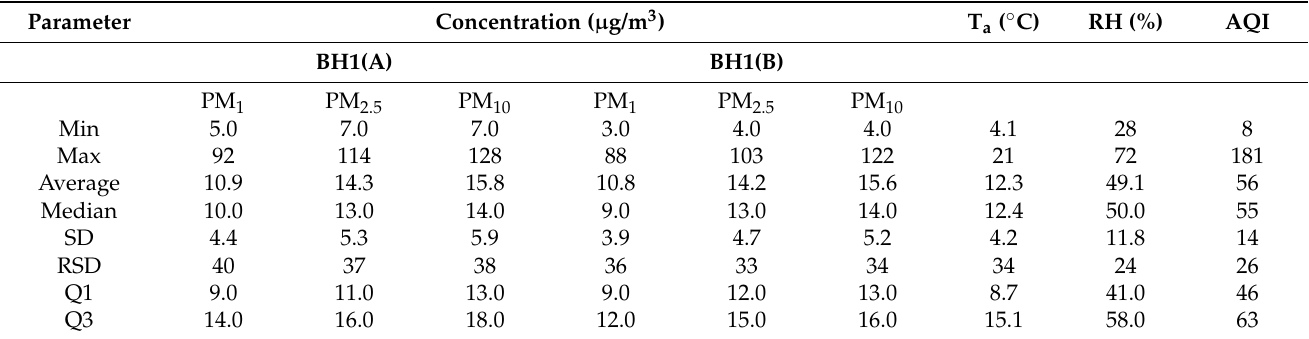
Table 3. Statistics of air monitoring data recorded with BH1 sensors collected outdoors at the urban